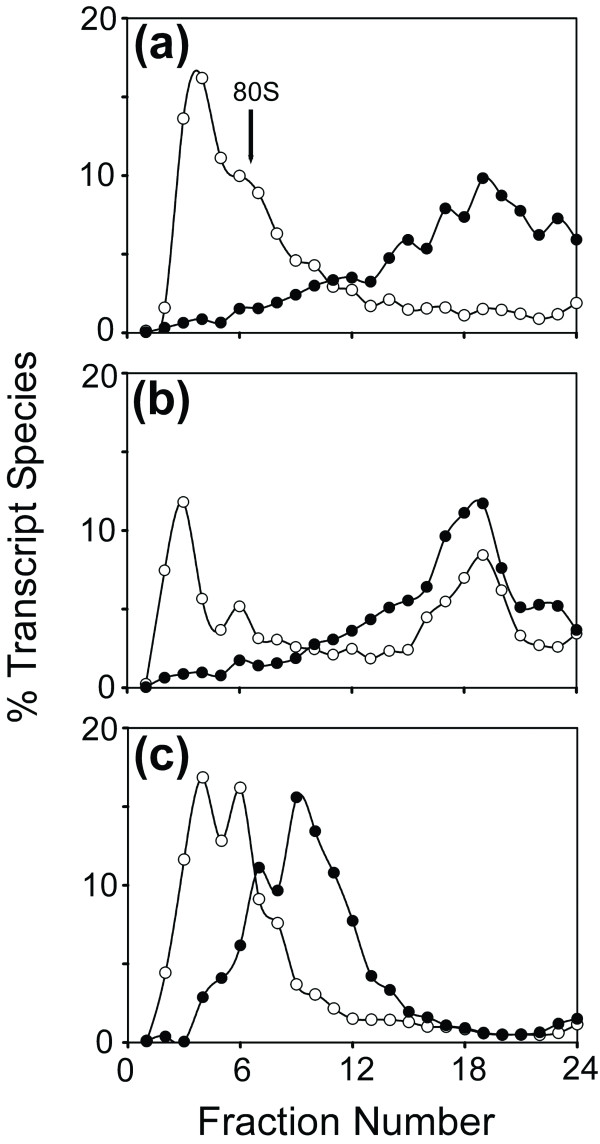
Changes in ribosome loading in response to nitrogen starvation. mRNA levels across sucrose gradient from growing cells (open circles) and from cells nitrogen starved for 30 minutes (filled circles) for (a) DAL5, (b) UGA1 and (c) GCN4. RNA was prepared and analyzed as described in Figure 2. The top of the gradient is to the left and the position of the 80S monosome is marked with the arrow. The experiments shown in (a) and (b)were performed with strain LL1 (Δgcn2 ; described in Materials and methods) and the experiment in panel c was conducted with the wild-type strain.